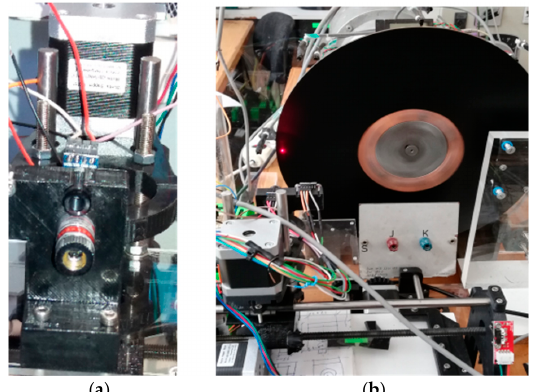
Figure 13. ( a ) Detail of the infrared temperature sensor MLX90614 and laser pointer; ( b ) CNC to position the infrared sensor and measure the temperature at di ff erent points on the disk.